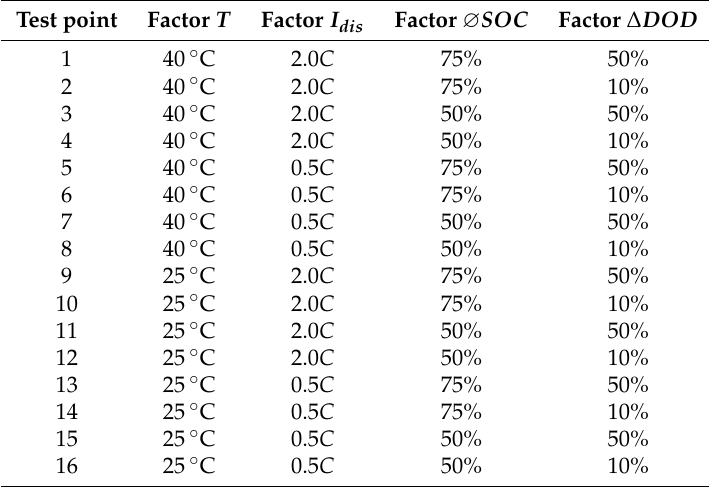
Table 4. Test matrix for test series A: Full factorial test design.